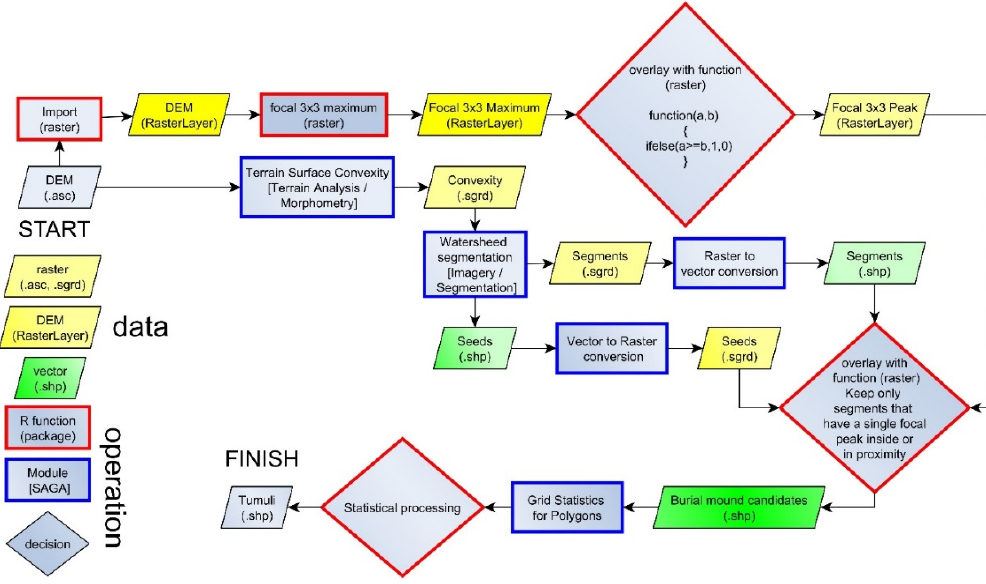
Figure 5. The proposed workflow. (a high-resolution version can be found at https://doi.org/10.6084/m9.figshare.11798634.v1)